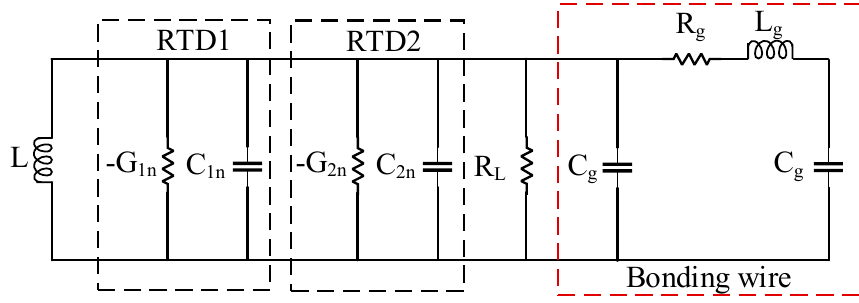
Figure 10. Packaged RTD equivalent circuit including gold wire bonding. Electronics 2020 , 9 , x FOR PEER REVIEW